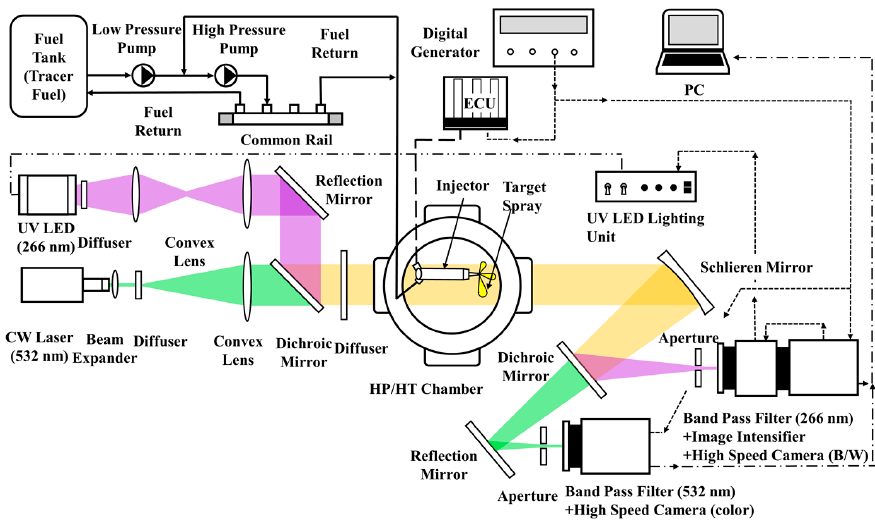
Figure 2. High-Speed Laser Absorption Scattering (HS-LAS) schemes with optical system and constant volume chamber.